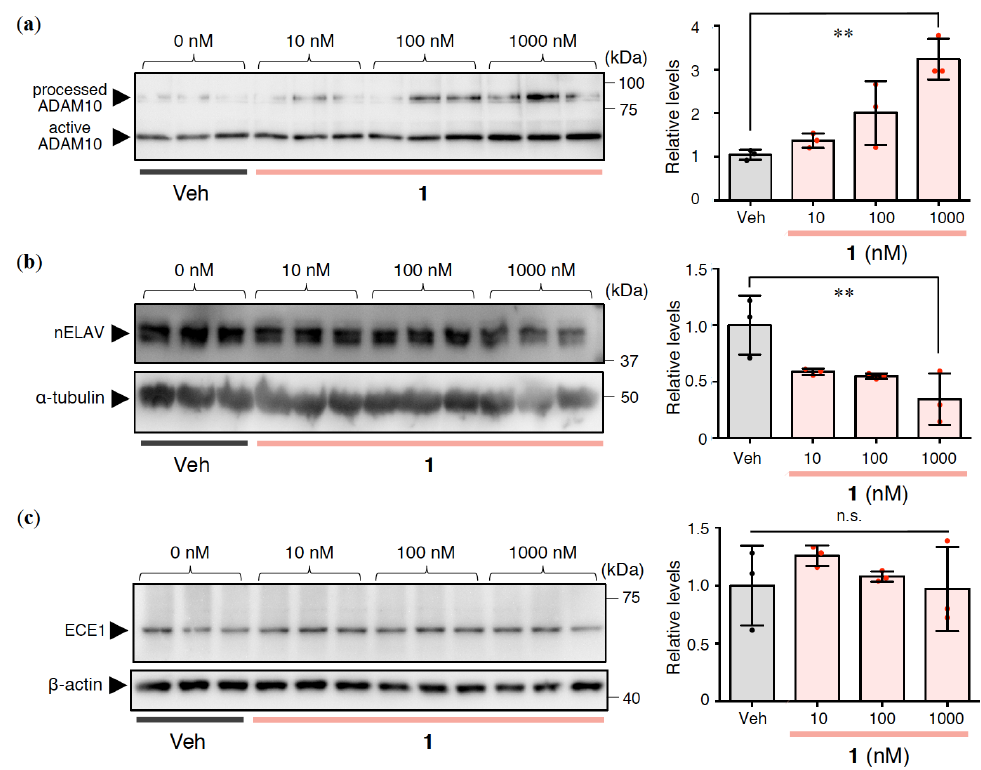
Figure 3. ( a ) Processed ADAM10, ( b ) nELAV, and ( c ) ECE1 in the cell lysate prepared from rat primary cerebral cortex cells treated with 1 at indicated concentrations for 24 h. The relative levels of ( a ) active ADAM10, ( b ) α -tubulin, and ( c ) β -actin are presented as mean ± SD ( n = 3). ** p < 0.01 versus Veh (vehicle). n.s.: not significant. Red or black dots represent each value.